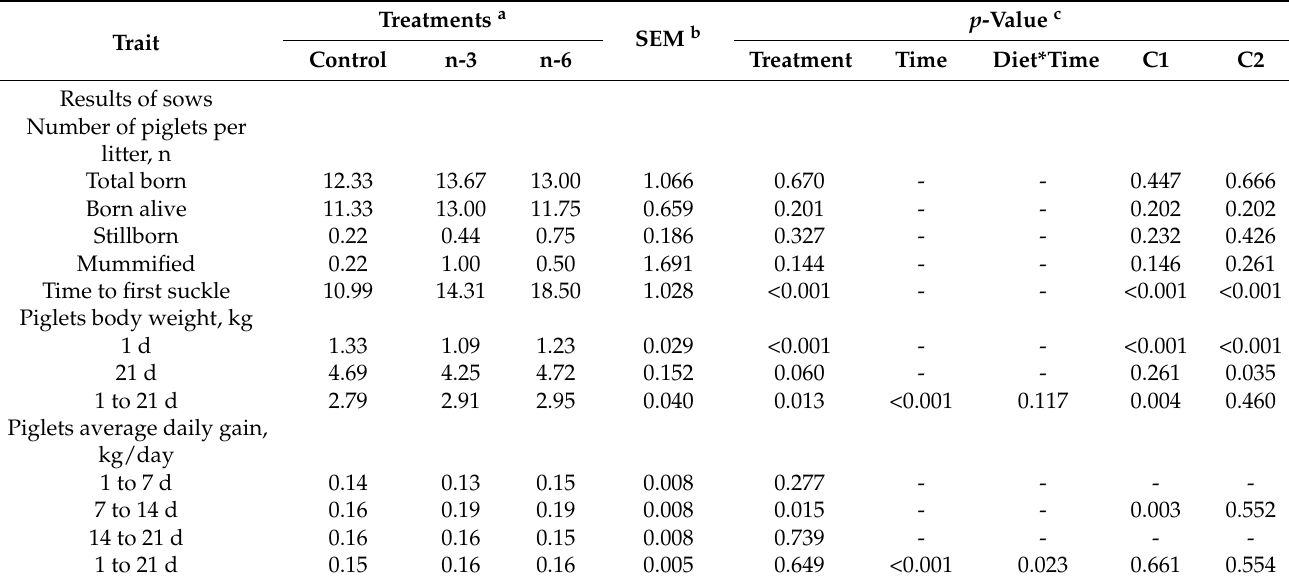
Table 11. Sow’ reproduction traits and piglet’s performance.